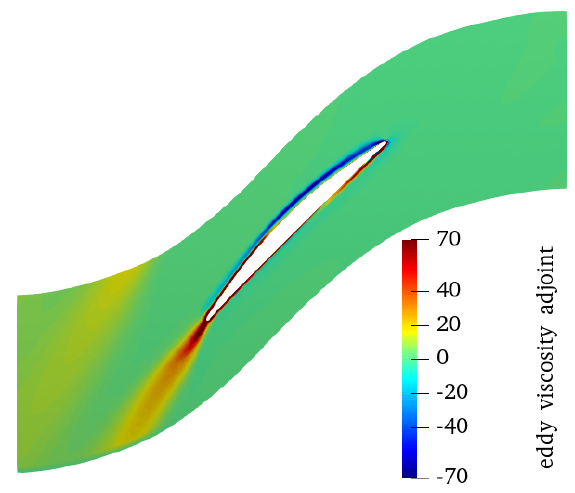
Figure 7. The eddy viscosity adjoint field with the mass flow rate as the performance functional at the design